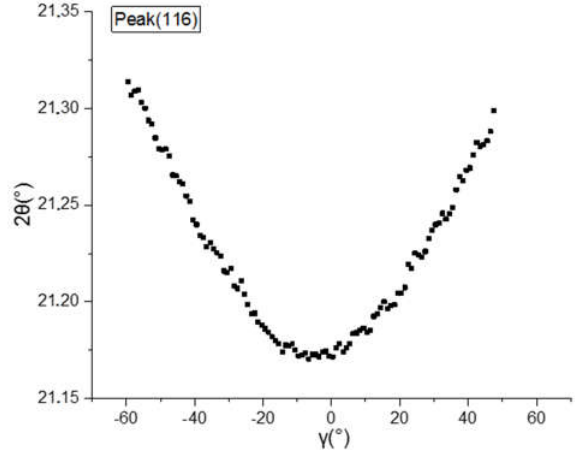
Figure 9. 2 θ versus γ for the peak (116) in the Figure 9. 2θ versus γ for the peak (116) in the oxide.